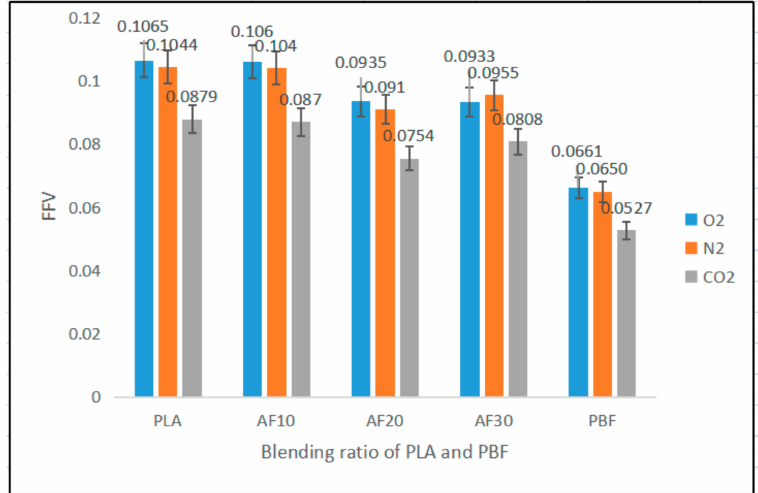
Figure 10. FFV of O 2 , N 2 , and CO 2 in PLA, PBF, and blends. p < 0.05; error bars indicate SD; n =